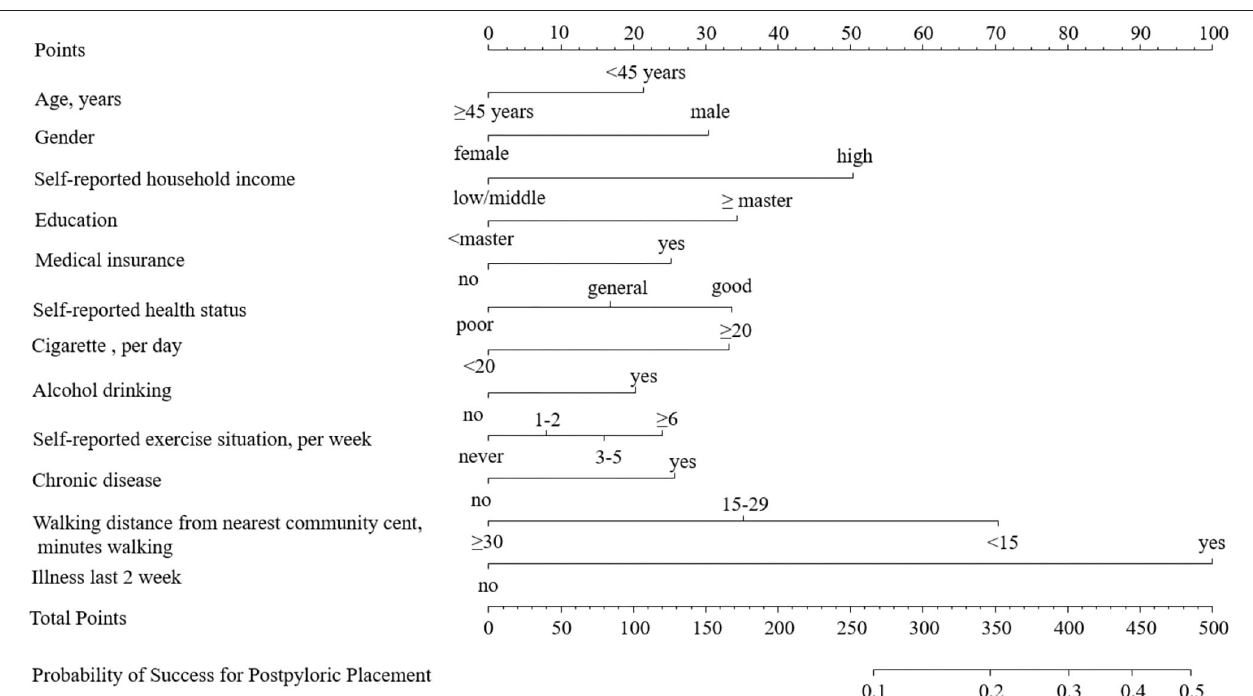
FIGURE 3 | The nomogram for the family doctor contract service. The points of each predictor were firstly determined by drawing a vertical line from the factor to the point axis. The sum of all the points from all predictors was then used to generate the total points. By drawing a vertical line from the total point axis to the risk of RAS axis, the estimated probability of the family doctor contract service could be